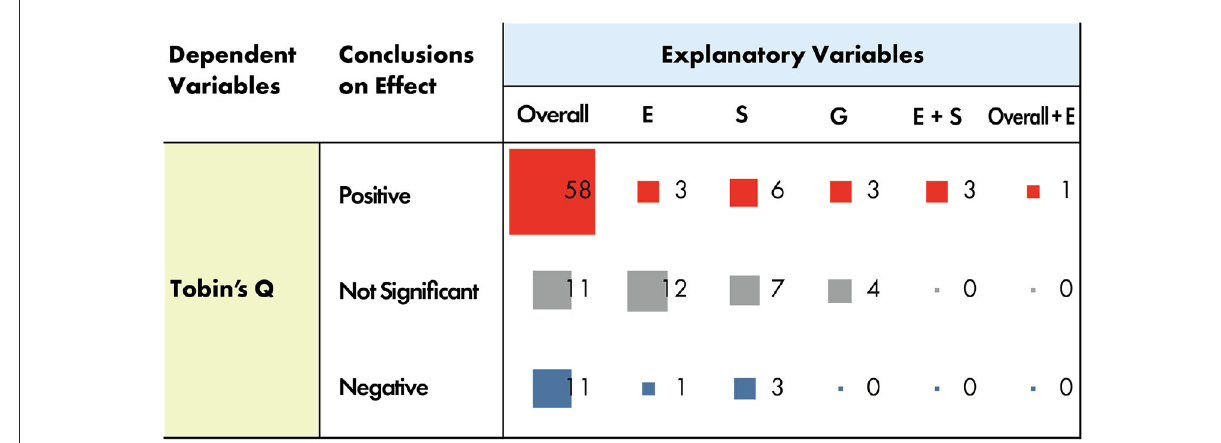
FIGURE6 Heatmap of the results of the studies with Tobin’s Q as dependent variables.